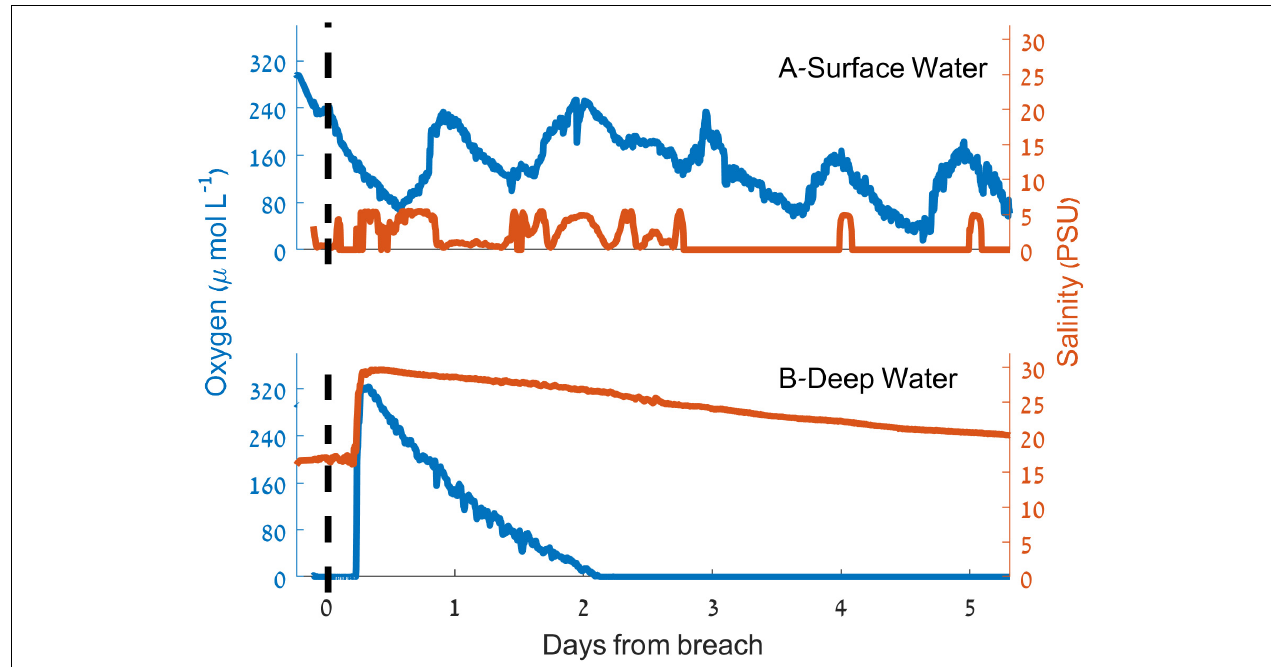
FIGURE 6 | Dynamics of salinity (red) and dissolved oxygen concentration (blue) during the sandbar breaching experiment. (A) Surface water. (B) Deep water. The vertical dashed lines indicate the time of the